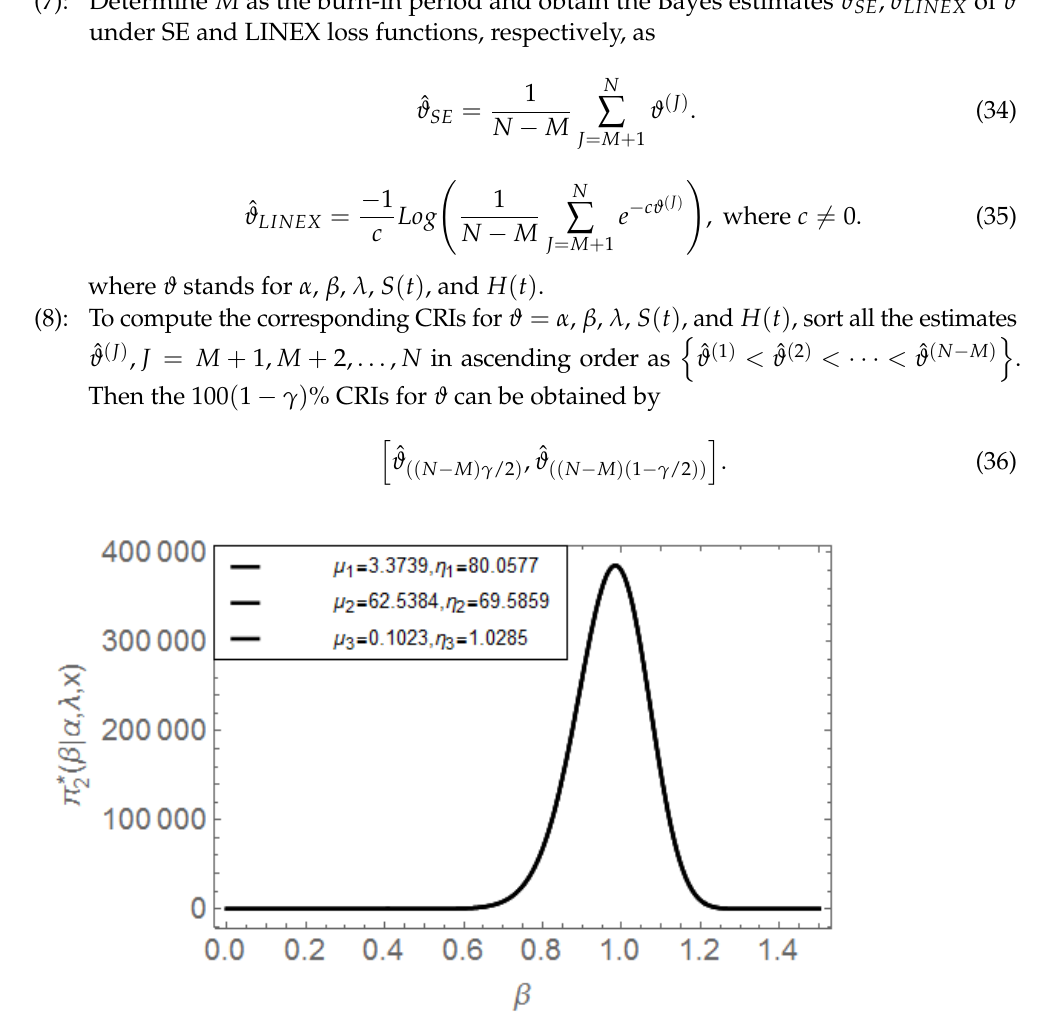
Figure 1. Posterior density function π ∗